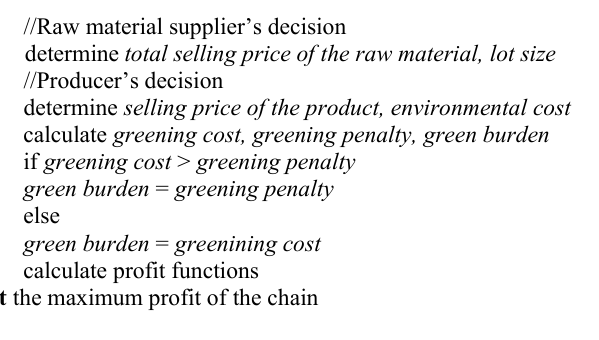
Fig. 1 The procedure of the proposed